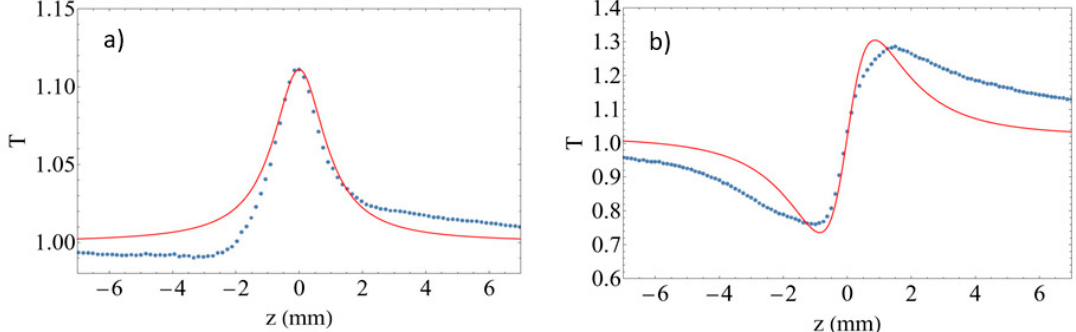
Figure 6. Z-scan results obtained with 98 fs pulses at 800 nm using a 300 mW average power (corresponding to a pulse energy of 4 nJ); ( a ) open-aperture results, showing the signature of saturable absorption, and ( b ) closed-aperture z-scan, showing a positive nonlinear refractive index. Dot lines represent experimental data and solid lines correspond to numerical fiting.